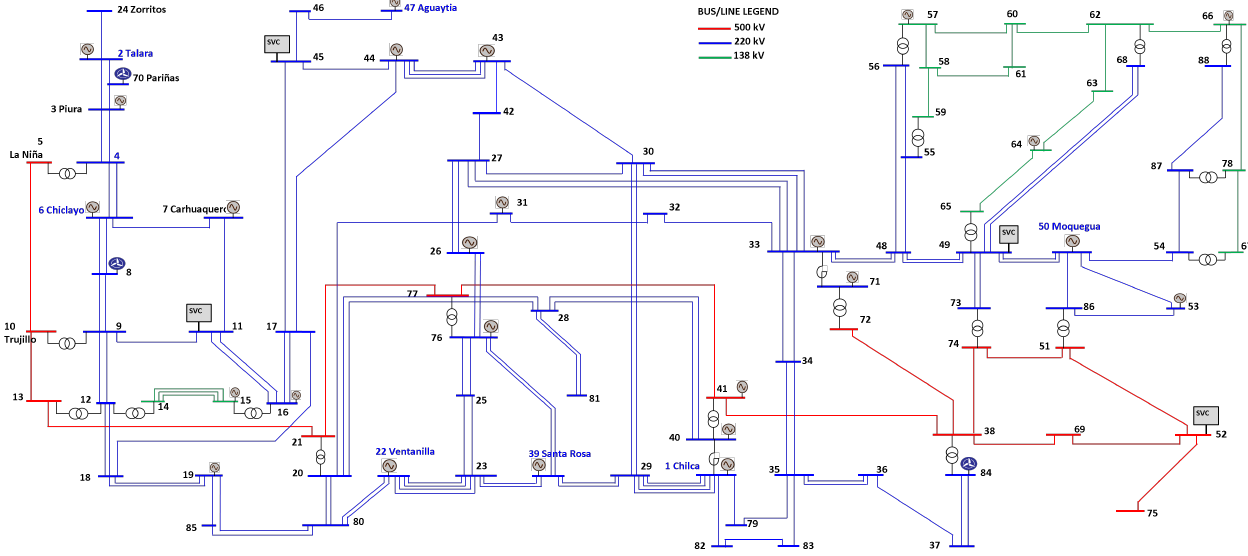
Figure 1. Single line electrical diagram in 500, 220, and 138 kV (88 bus).